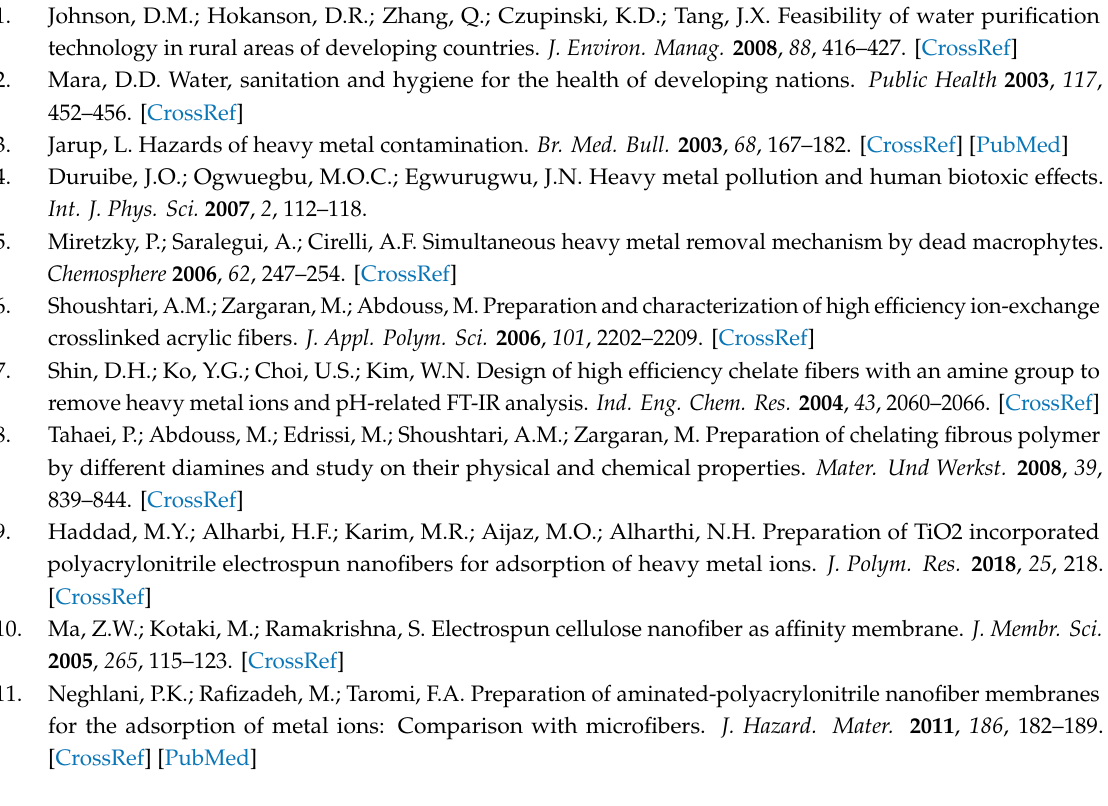
Figure S1: Point of zero charge (pH pzc ) of the bilayer PAN / MO–CS nanofiber mat; Figure S2: Linear fitting of the PFO and PSO models for the adsorption of cadmium onto PAN–CS and PAN / MO–CS nanofiber mats; Figure S3: Fitting of the Dubinin–Radushkevich model for the adsorption of lead and cadmium onto PAN–CS and PAN / MO–CS nanofiber mats; Table S1: Comparison of kinetics parameters of the PSO model for the adsorption of cadmium obtained by linear fitting and nonlinear optimization methods; Table S2: Parameters of the Dubinin–Radushkevich equation and the mean adsorption energy E for the adsorption of lead and cadmium by PAN–CS and PAN / MO–CS